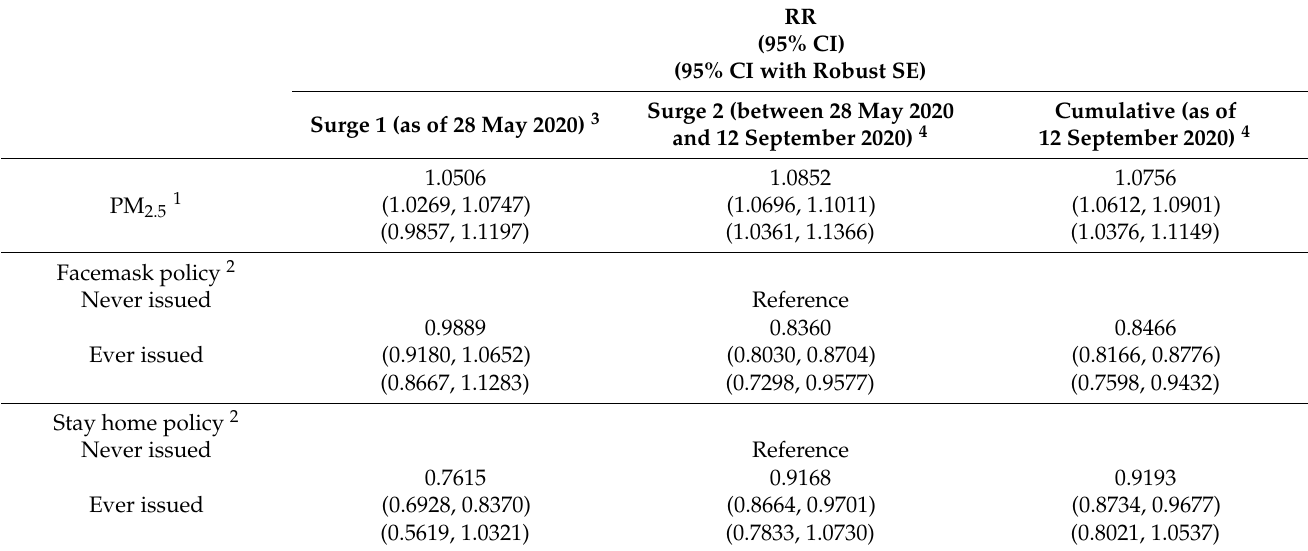
Table 4. Adjusted RRs of COVID19 associated with 1- µ g/m 3 increase in PM 2.5 , facemask policy and stay home